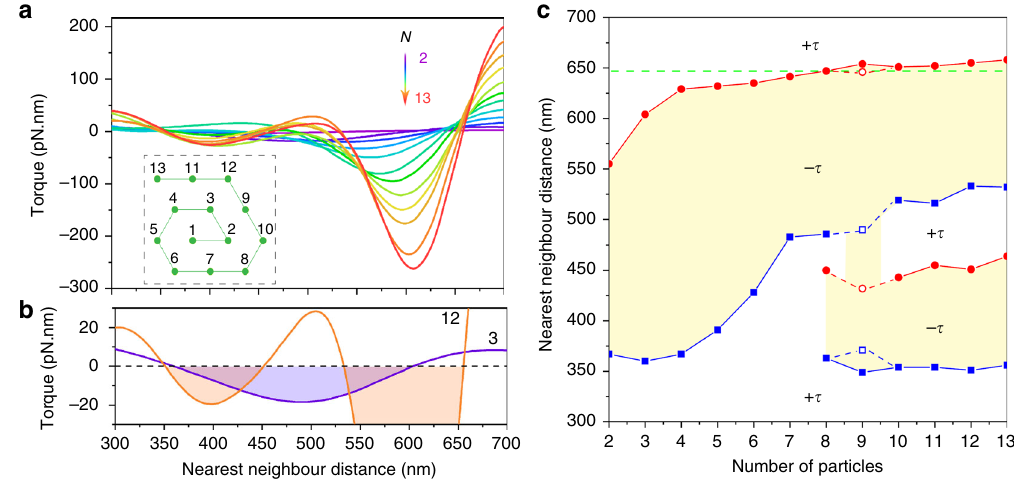
Fig. 3 FDTD simulation of optical torques in static optical matter arrays composed of ideal hexagonal NP lattices with varying lattice constants. a Calculated optical torque in type-I arrays with increasing number of particles ( N ) and lattice constants. The inset illustrates the con fi gurations of the arrays. b Zoom-in view of the torque vs nearest neighbor separation highlighted for the 3-I and 12-I arrays, where the negative torque regions are shaded. c An optical torque “ phase diagram ” where the torque direction of an array depends on its lattice constant (i.e. interparticle spacing) and number of particles. The solid symbols are boundaries separating regions of positive and negative torque, and the open symbols at 9 particles is for a 9-III array. The green dashed horizontal line at 647 nm interparticle separation indicates the torque crossover at 8 particles in reference to Fig.